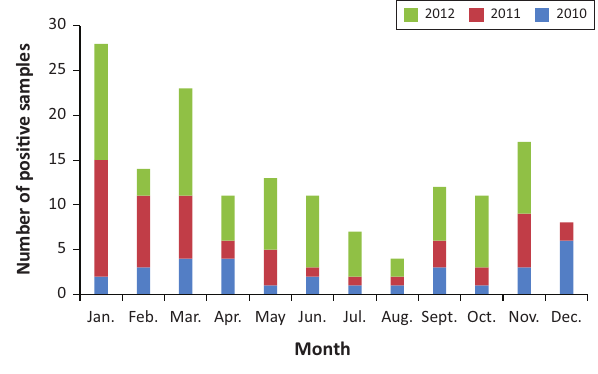
FIGURE 3: Total number of positive specimens in the acute flaccid paralysis surveillance programme by month, for 2010–2012.